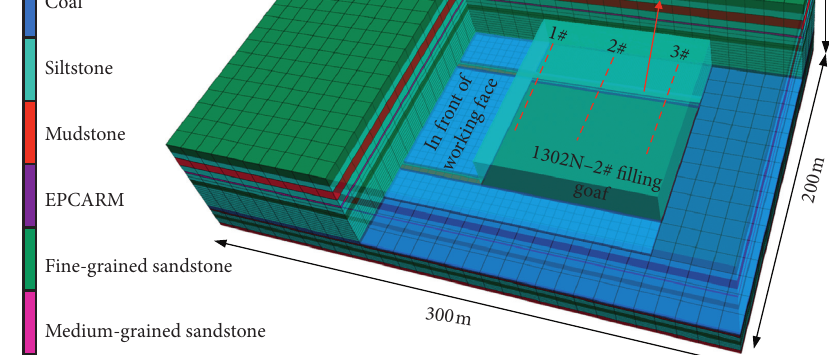
Figure 4: Numerical